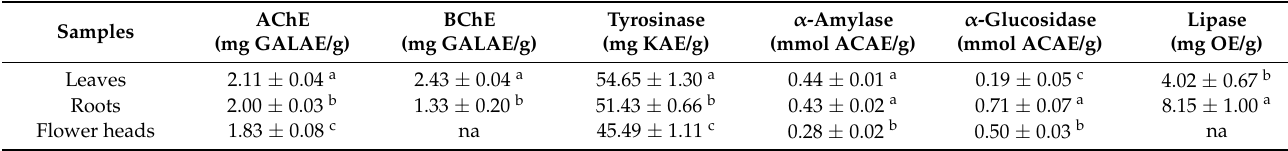
Table 4. Enzyme inhibitory activity of the T. balsamita